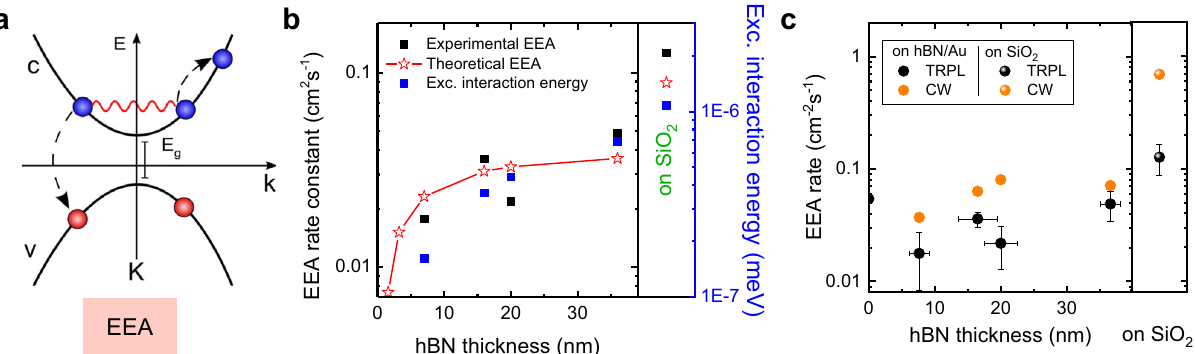
Fig. 5 Theoretical model. a Schematic of the nonradiative Auger scattering mechanism considered in the calculations. For this direct process, electrons from two different excitons interact via the screened potential obtained from Eq. (3). This induces the recombination of one exciton, whose energy and momentum are transferred to the other exciton, thus yielding a fi nal state composed by a single unbound electron-hole pair. b Log-log plot of the measured EEA rate constant as a function of hBN thickness on Au (black squares from Fig. 3f), along with the direct Auger scattering rate constants (red stars) fi tted by Eq. (4) with a proper scaling factor, and the average energy of exciton-exciton pairs at the exciton density of 1 × 10 11 cm − 2 (blue squares). A comparison between the trends in these results as a function of hBN thickness, as well as for 1L-WS 2 on SiO 2 , (see symbols in the left of the panel) shows a reasonably good consistency between the measured EEA rate constants, the theoretically estimated nonradiative scattering rate constants and the exciton-exciton interaction energies. c Comparison of the EEA rates calculated from the TRPL experiments (the same data set as in Fig. 3f) and from the CW measurements of a-QYs, showing the same trend of increasing the EEA rate with increasing the hBN thickness on Au and highest on SiO 2